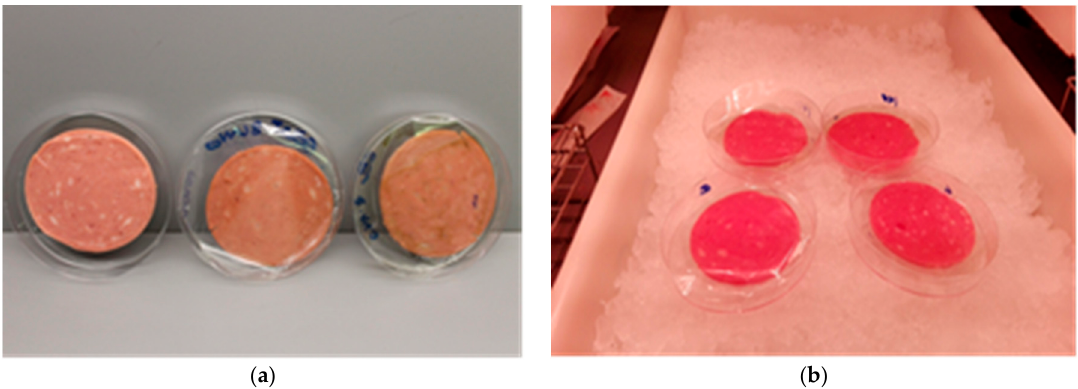
Figure 1. Example of test: ( a ) from left to right: bologna slice without coating, sample with a control gelatin (G) coating on poly(ethylene terephthalate) (PET), and sample of G-coated PET containing E-140 porphyrin; ( b ) image of an experiment of treatment during the photoactivation process.